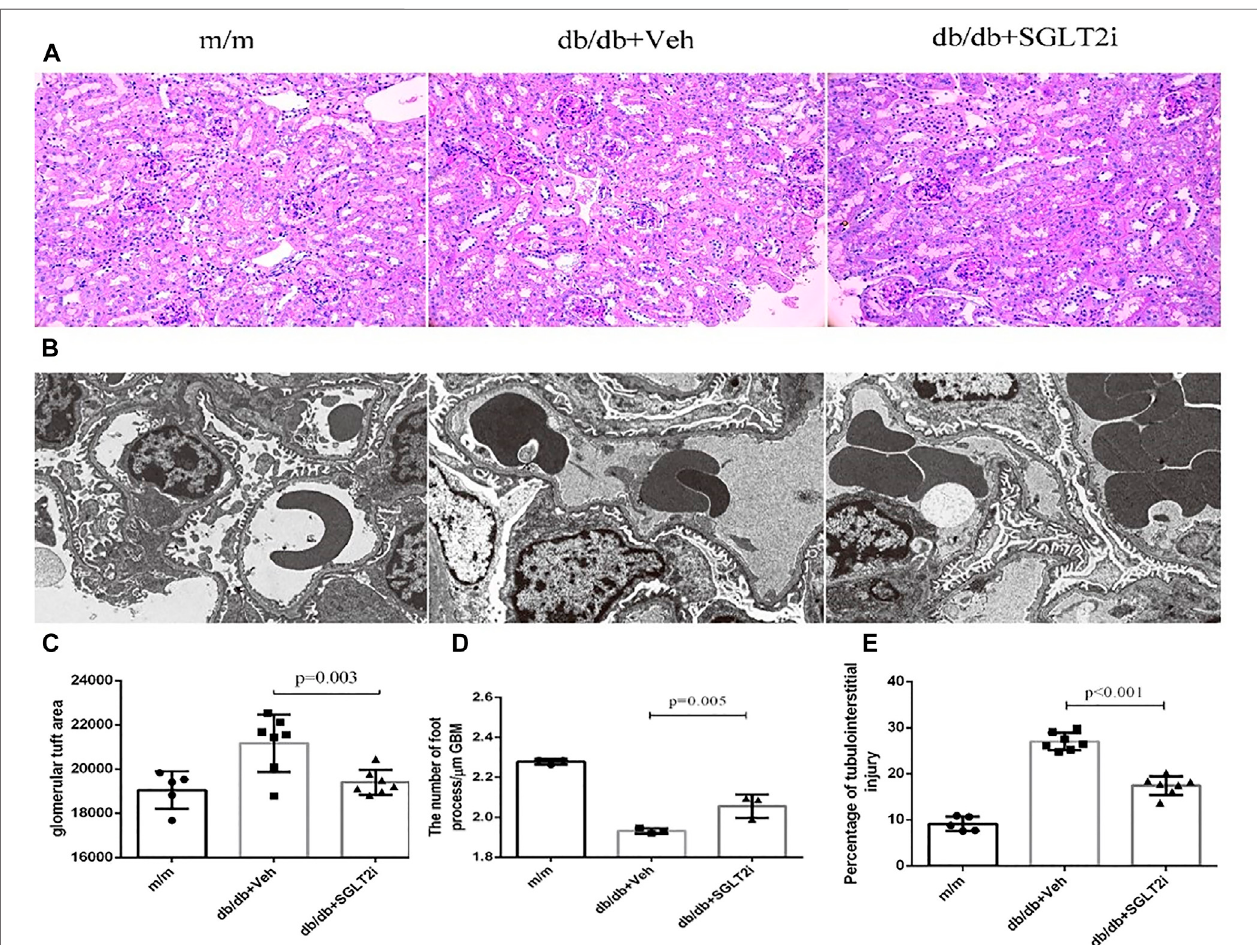
FIGURE 1 | Dapagli fl ozin ameliorated diabetic kidney disease in db/db mice. (A) Representative PAS staining of kidney biopsy from m/m mice ( n (cid:2) 5), vehicle- treated db/db mice ( n (cid:2) 7) and SGLT2i-treated db/db mice ( n (cid:2) 7) showing mesangial matrix expansion, Bar (cid:2) 100 μ m. (B) Representative ultrastructure changes of GBM by electron microscopy under × 10000 magni fi cation, n (cid:2) 3 for each group. (C) Semiquantitative analysis of mesangial matrix expansion. (D) The number of foot processes. (E) Semiquantitative analysis of tubulointerstitial injury. PAS, periodic acid-Schiff; SGLT2i, sodium-glucose cotransporter 2 inhibitor; GBM, glomerular basement membrane; MPTEC, mouse proximal tubular epithelial cell; DMOG, dimethyloxallyl glycine.